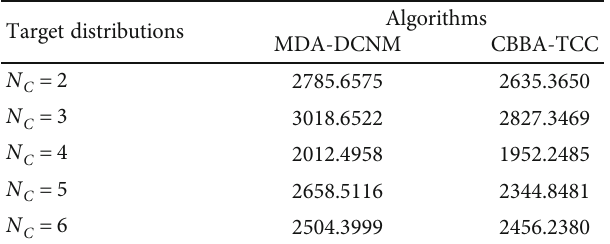
Table 5: Scores of two algorithms under di ff erent target